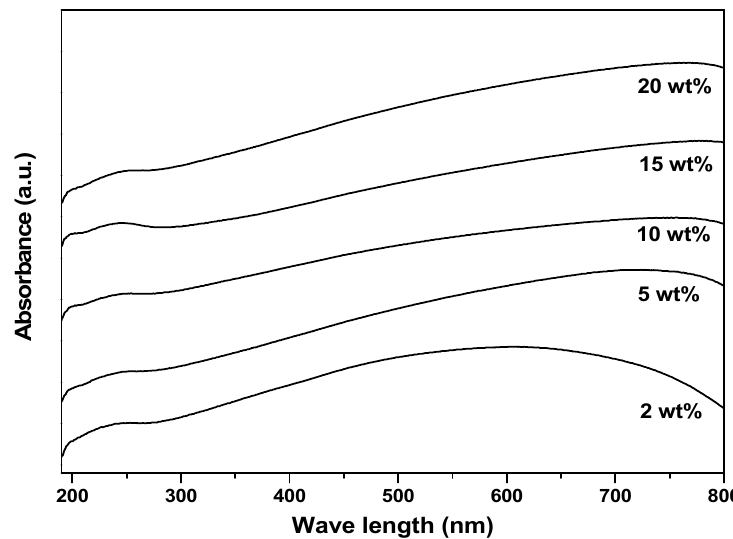
Figure 5. UV–Vis DRS profiles of various Cu/SiO 2 catalysts.